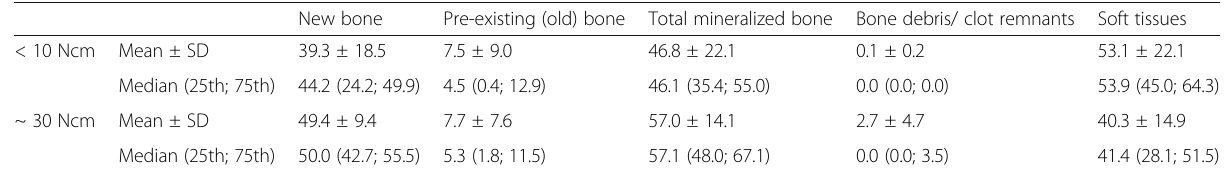
Table 1 Percentages of tissues in contact with the implant surface after 8 weeks of healing. Mean percentages ± standard deviations (SD), medians, and 25th and 75th percentiles (25 th ; 75 th ) of tissues components on the implant surface ( n = 11) Pre-existing (old) bone Total mineralized bone Bone debris/ clot remnants Soft tissues